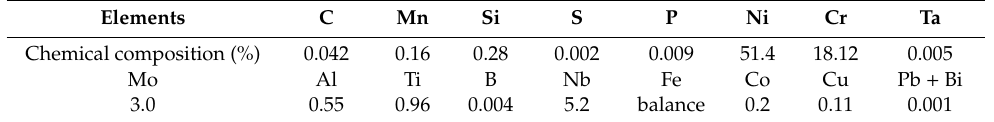
Table 1. Chemical composition of Inconel 718 material.